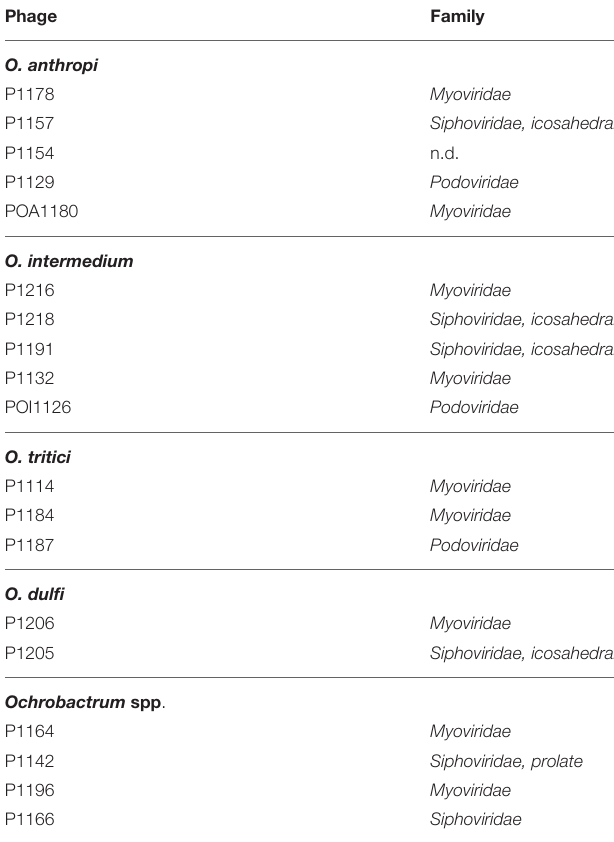
( Figure 3A ), genome sizes between 32 and 63 kb were calculated (data not shown). To determine DNA homologies between the phages, Southern hybridizations were performed using three phage DNAs as probes; myovirus POA1180 isolated from O. anthropi ( Figure 3B ), podovirus POI1126 ( Figure 3C ) isolated from O. intermedium and B. inopinata phage BiPBO1 ( Figure 3D ), which already revealed significant homologies to some Ochrobactrum prophages (Hammerl et al., 2016). Phage POA1180 did not hybridize to most of the other phages. Weak homologies were detected to POI1126 and to the two O. dulfi phages whose restriction patterns were identical. Phage POI1126 hybridized strongly to the O. anthropi phage P1129 and to the O. tritici phage P1187. Moreover, the homologous restriction fragments were similar in size corroborating the close relationship of these phages. The temperate B. inopinata phage BiPBO1 showed relationship to the O. anthropi